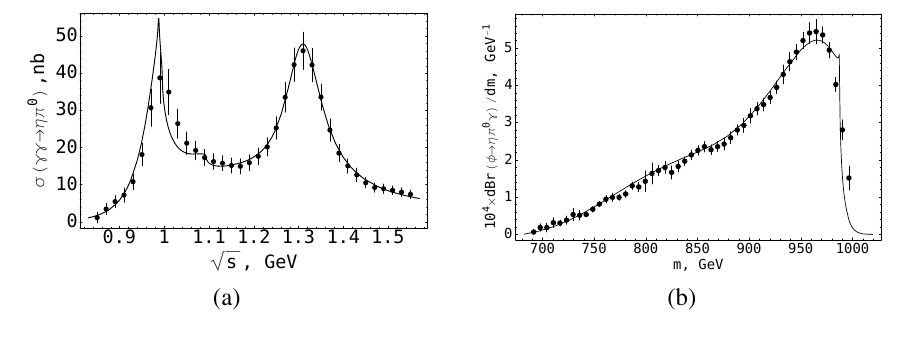
Figure 2. Results of our fit, see Tables I and II, on a) the Belle data on γγ → ηπ 0 cross-section [6], and b) the KLOE data on the φ → ηπ 0 γ decay [7], m is the invariant ηπ 0 mass.